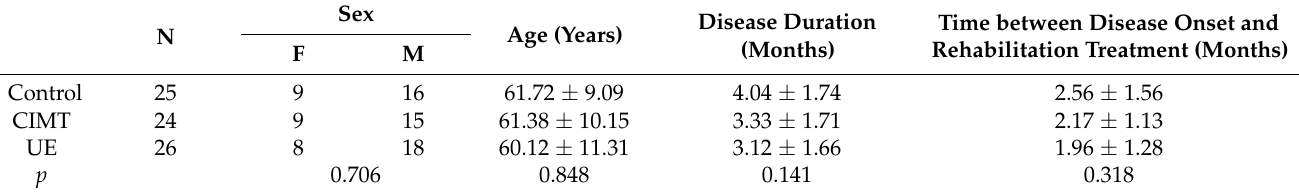
Table 2. The demographic characteristics.